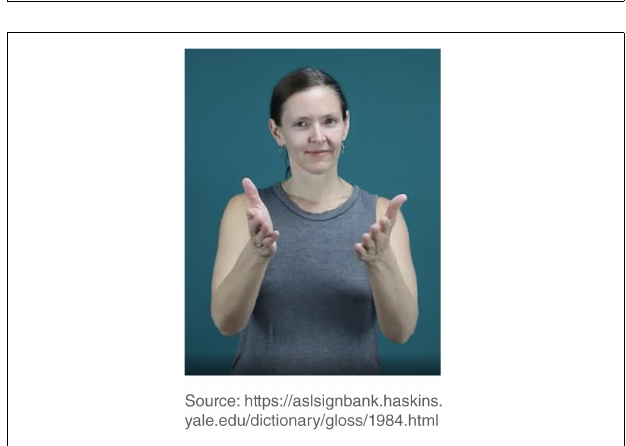
FIGURE 4 | The dictionary entry for CONVINCE . Source: https://aslsignbank.haskins.yale.edu/dictionary/gloss/1984.html. Images produced with permission, source information available in the Supplementary Material .